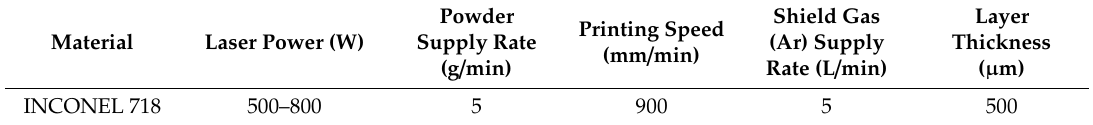
Table 5. DED process parameters used for printing INCONEL